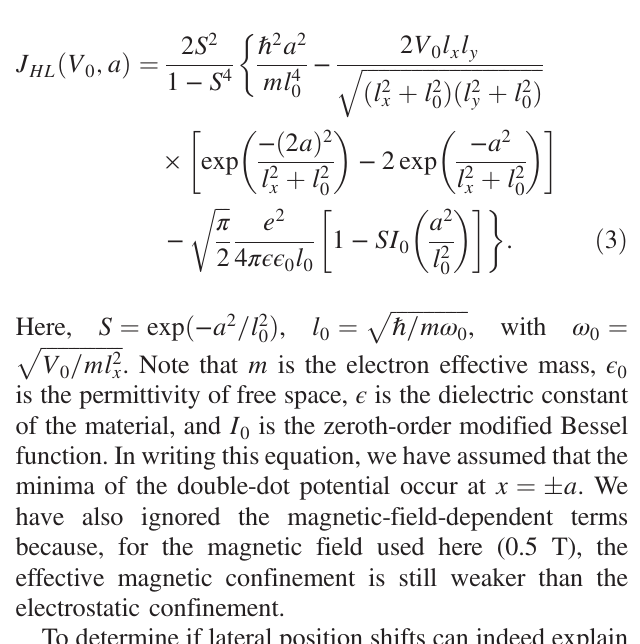
FIG. 2. Electrostatic simulations. (a) Line cuts of the simulated potential associated with dots 2 and 3 vs the barrier voltage pulse B 2 . The left dip is the potential of dot 2, and the right dip is the potential of dot 3. The dots move closer together as B 2 increases. The dashed lines are guides to the eye. (b) Fitted parameters of the simulated double-dot potential vs B 2 . Based on the simulated potential of dot 1 (not shown), we also find that dots 1 and 2 move farther apart during the sample